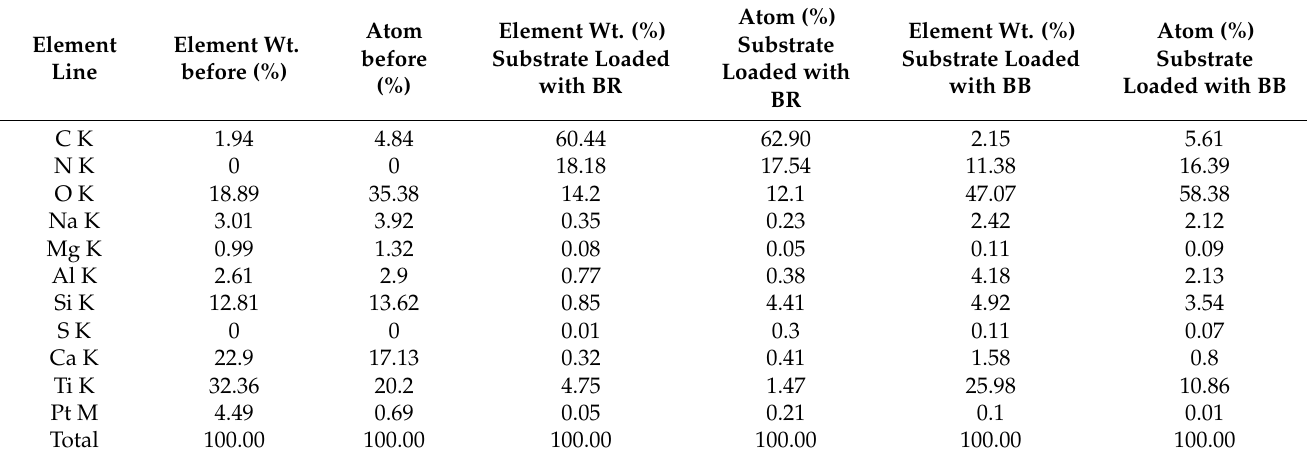
Table 4. Surface composition, in element Wt.% and atomic %, of the FADPt surface before and after loading with BR and BB dyes.